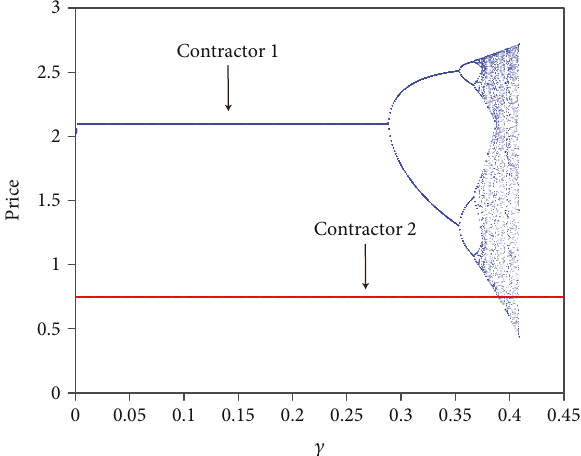
Figure 3: Price bifurcation diagram in situation 2.